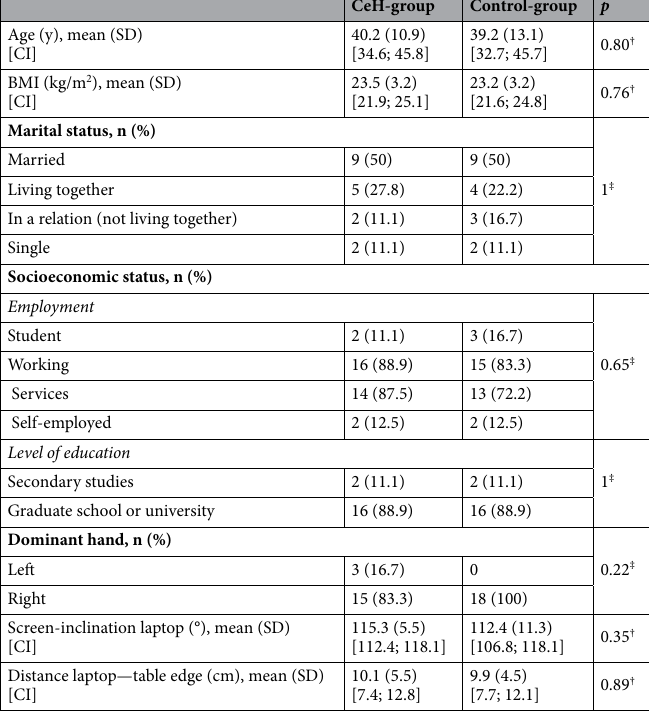
Table 1. Demographics and group characteristics of the CeH-group (n = 18) and control-group (n = 18). SD = Standard Deviation; CI = 95% Confidence Interval; n = number participants; y = years; † = unpaired t test; ‡ = contingency table for categorical variables (Fisher’s exact test); cm = centimetre.